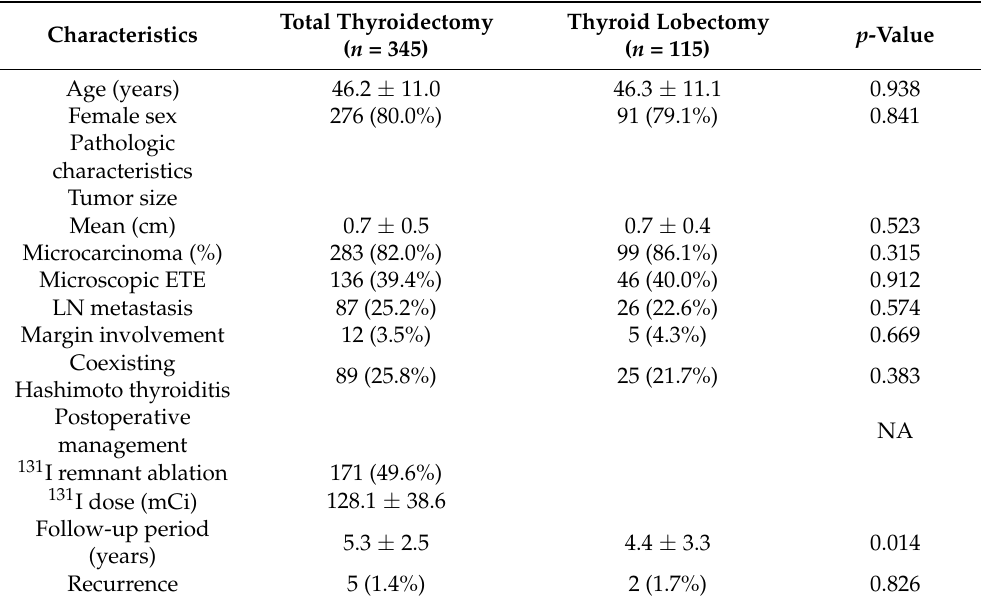
Table 2. Comparison of clinicopathological characteristics between lobectomy and total thyroidec- tomy groups after